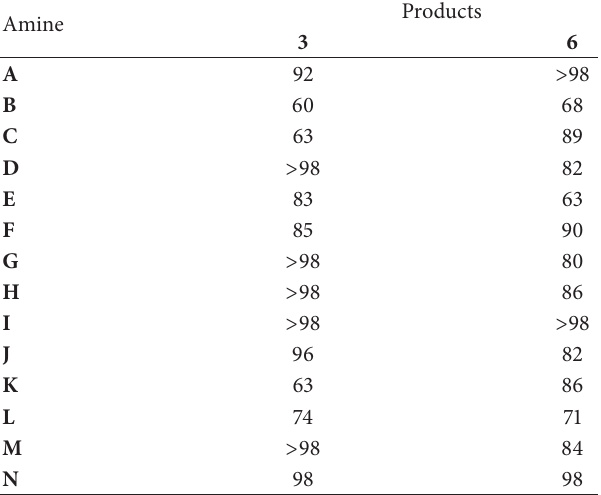
Table 1: Yields for bis(carbamoylcarboxylic) acids.